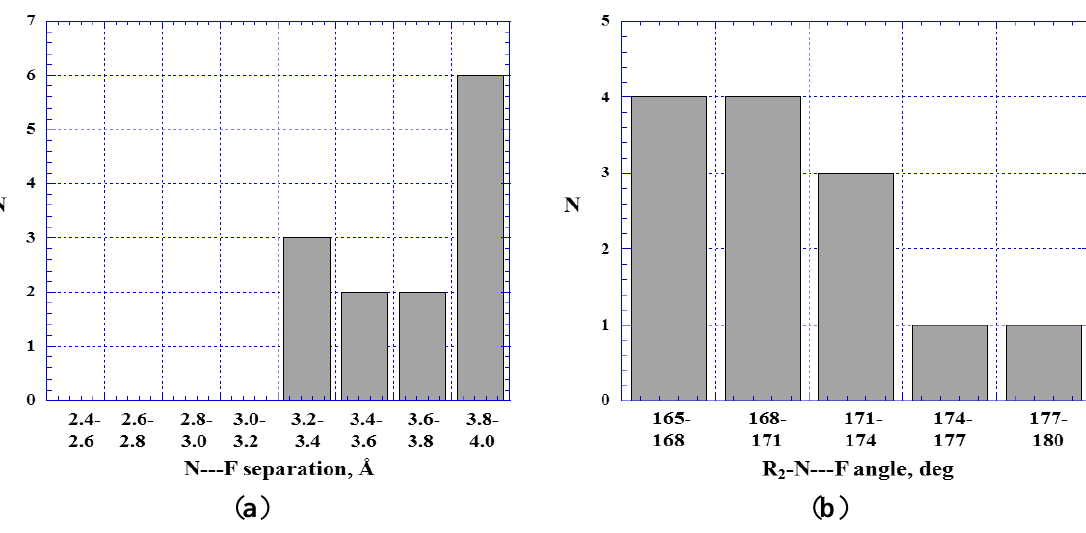
–N---F– close contacts at various N---F 2